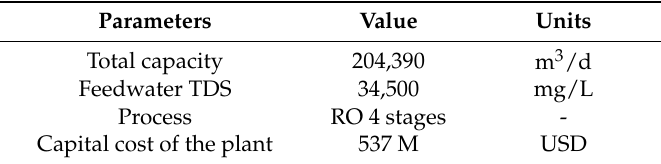
Table 3. Basic data of the Carlsbad Desalination Plant, in San Diego County [25].